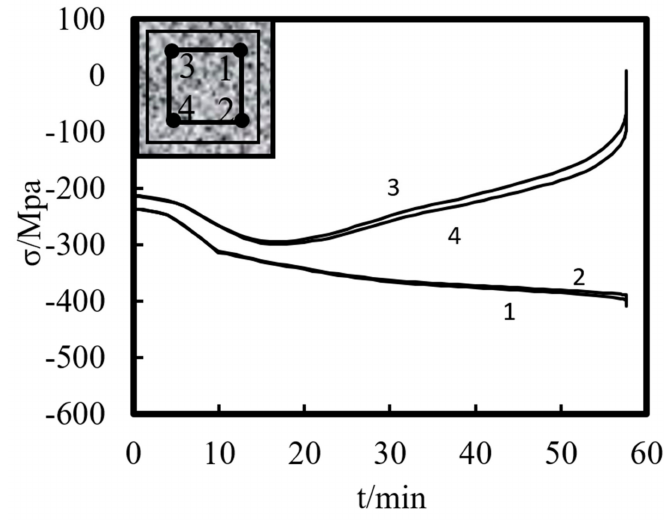
Figure 14. Stress–time curve of the internal steel tube at various points in the half-height section.